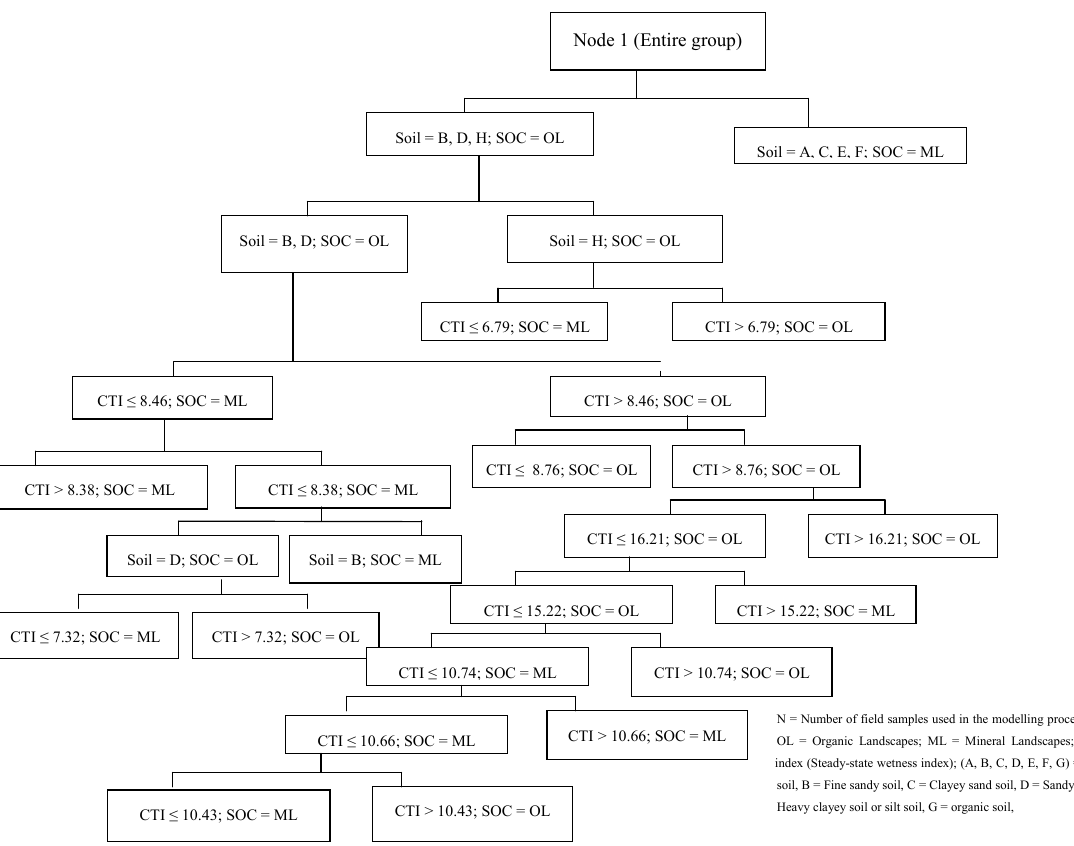
Fig. 2. Classification-tree model based on the combination of soil type and steady-state wetness index for predicting the spatial distribution of hydromorphic organic